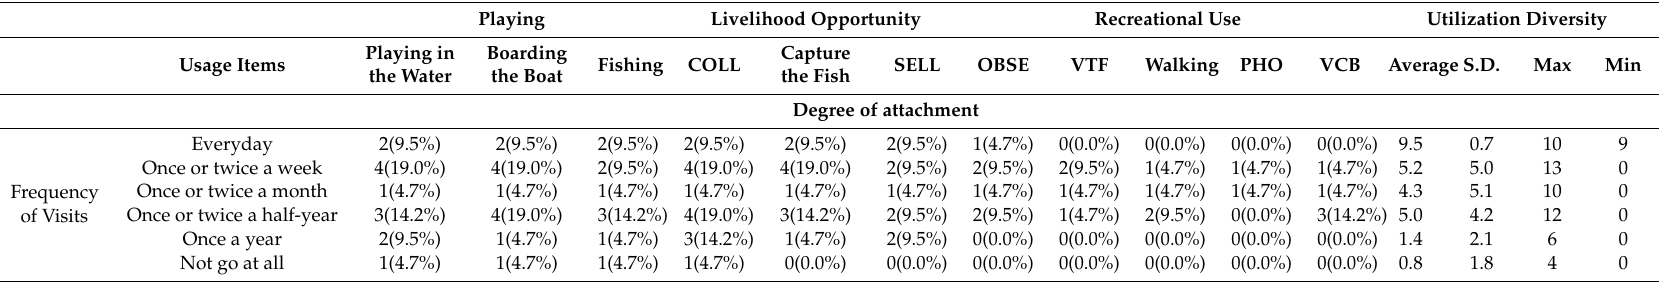
Table A4. The extent of attachment to the Fukushima-gata lagoon and actual use situation of the Fukushima-gata lagoon before reclamation project (n = 21).